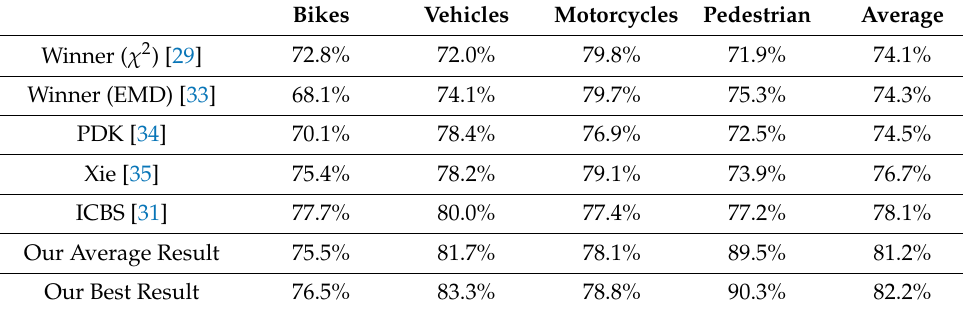
Table 4. Comparison results (EER) with other algorithms in